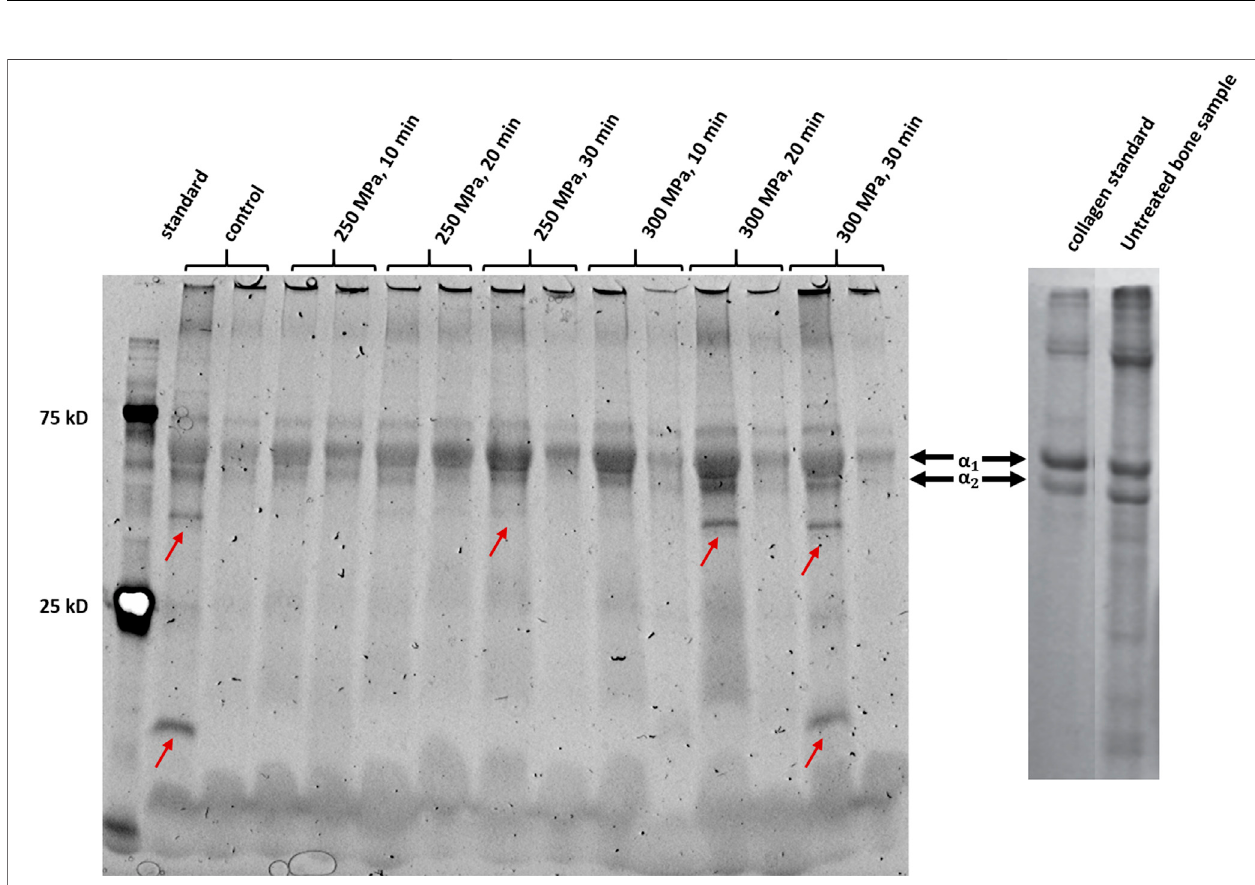
FIGURE 6 | Left picture: SDS-PAGE of HHP-treated and untreated bone samples. The Precision Plus Dual Color Standard (BioRad Laboratories) with the speci fi c bands at 25 kD and 75 kD was applied in the fi rst lane from the left. Red arrows show conspicuous bands that occur only sporadically in some samples. Picture shows samples, which were shock-frozen immediately after HHP-treatment (incubation period 0 h). Right picture: Reference SDS-PAGE of an untreated bone sample, with a collagen standard for bone (adapted from Açil et al., 2007) and self-edited.Prominentbands which can also be seen in the reference gel wereidenti fi ed asalpha-1 and alpha-2 chains of collagen